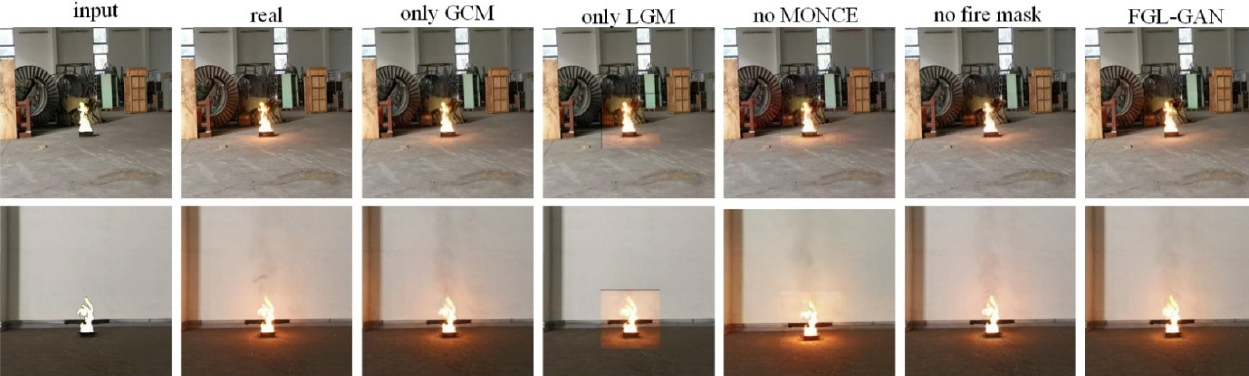
Figure 10. Ablation study of test sets.